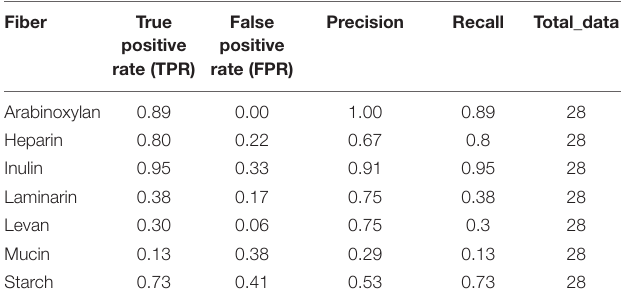
TABLE 1 | Performance of the FiberGrowth tool: the growth predictions for 28 genomes growing on seven fibers were compared to experimental data. Fiber True False Precision Recall positive positive rate (TPR) rate (FPR)